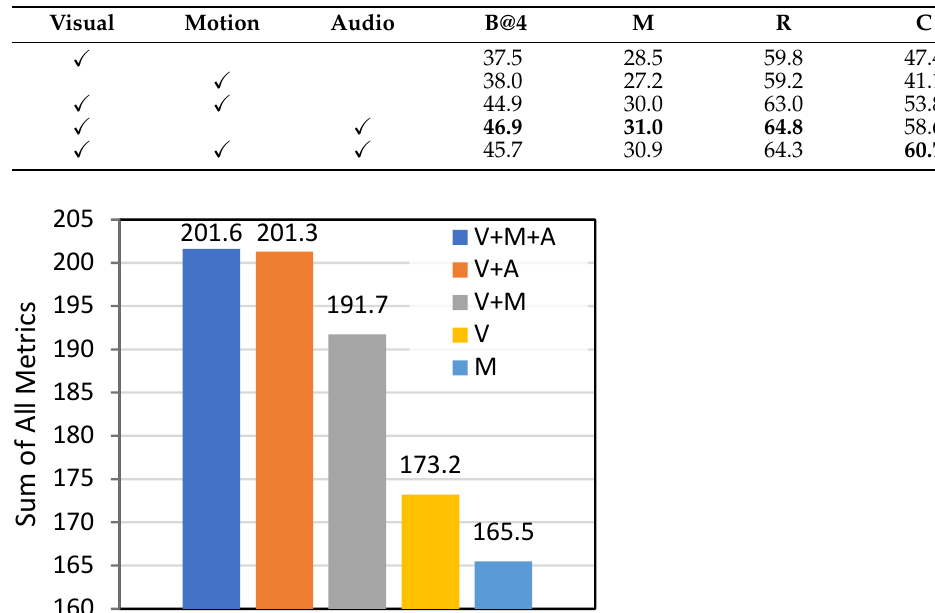
Table 2. Ablation study of modalities on MSR-VTT dataset. The modalities are fused by the baseline